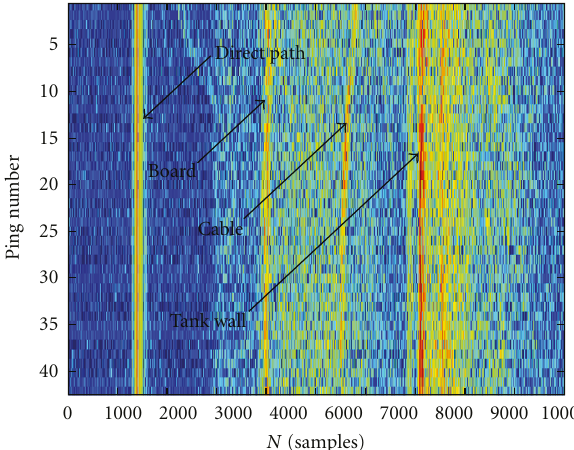
Figure 11: DC3 echoes at 5cm intervals along 2 m section of SL17L cable D(at 27 ◦ grazing angle).